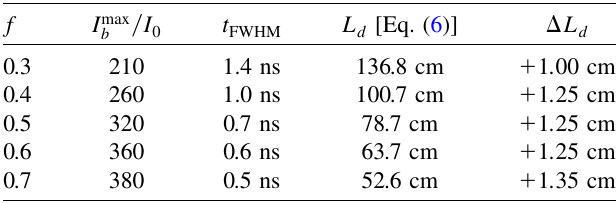
TABLE III. Compression dependence on the intended tilt f for (cid:4) 400 keV , T (cid:4) 0 : 2 eV , and t (cid:4) 300 ns using the smooth E k p 0 waveform across the 3 cm long